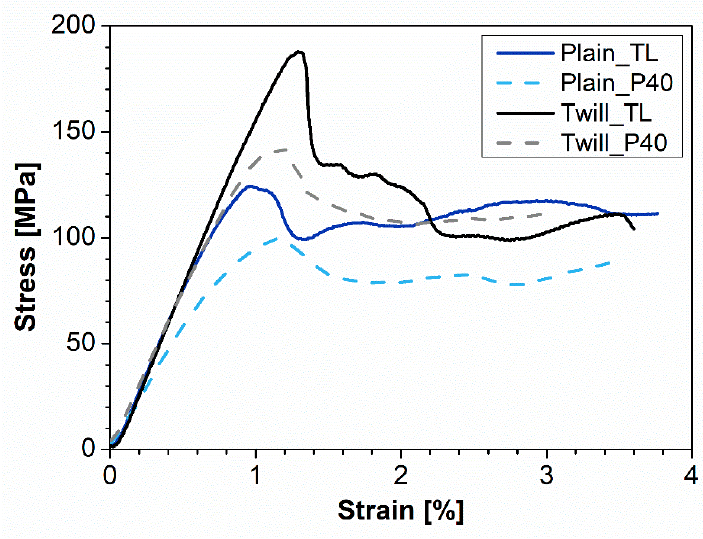
Figure 2. Representative flexural stress-strain curves for all investigated materials. Table 1. Mean values of flexural modulus (E f ) and maximum flexural strength ( σ f ) for each sample type. Standard deviations are reported in brackets.